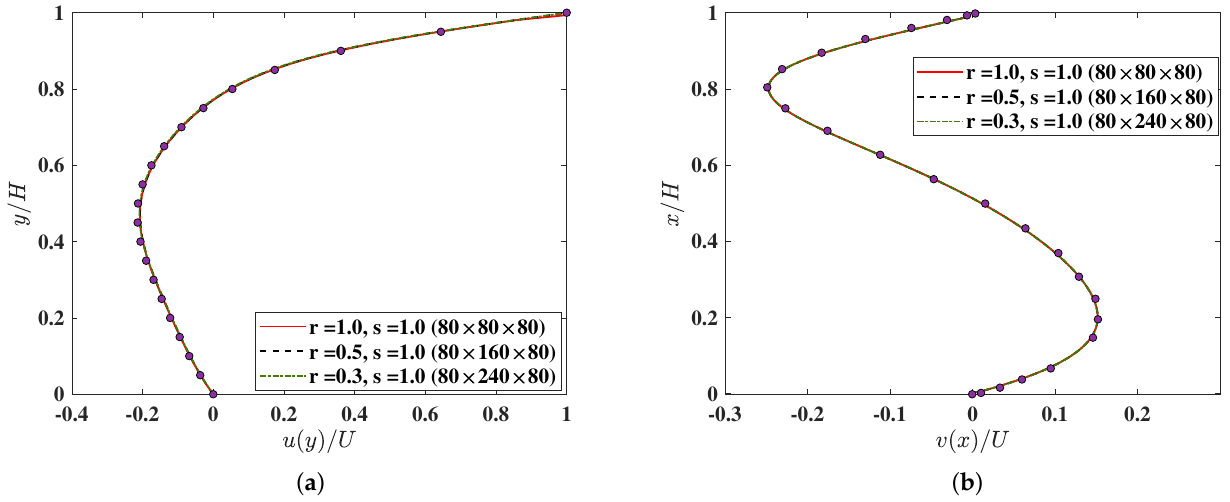
Figure 6. The velocity profiles along the centerlines of the 3D lid driven cavity flow for ( a ) u component along the y direction at x = 0.5 H and z = 0.5 H , and ( b ) v component along the x direction at y = 0.5 H and z = 0.5 H computed using the 3DCCM-LBM using three different aspect ratios and compared with the reference numerical solution from Shu et al. [58]